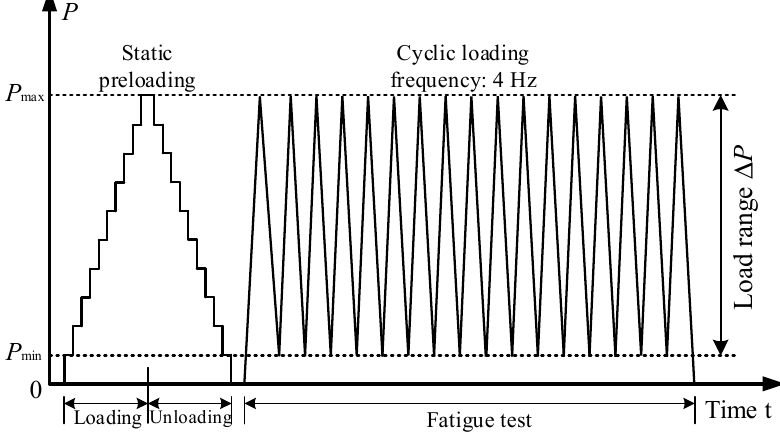
Figure 5. Fatigue loading procedure.